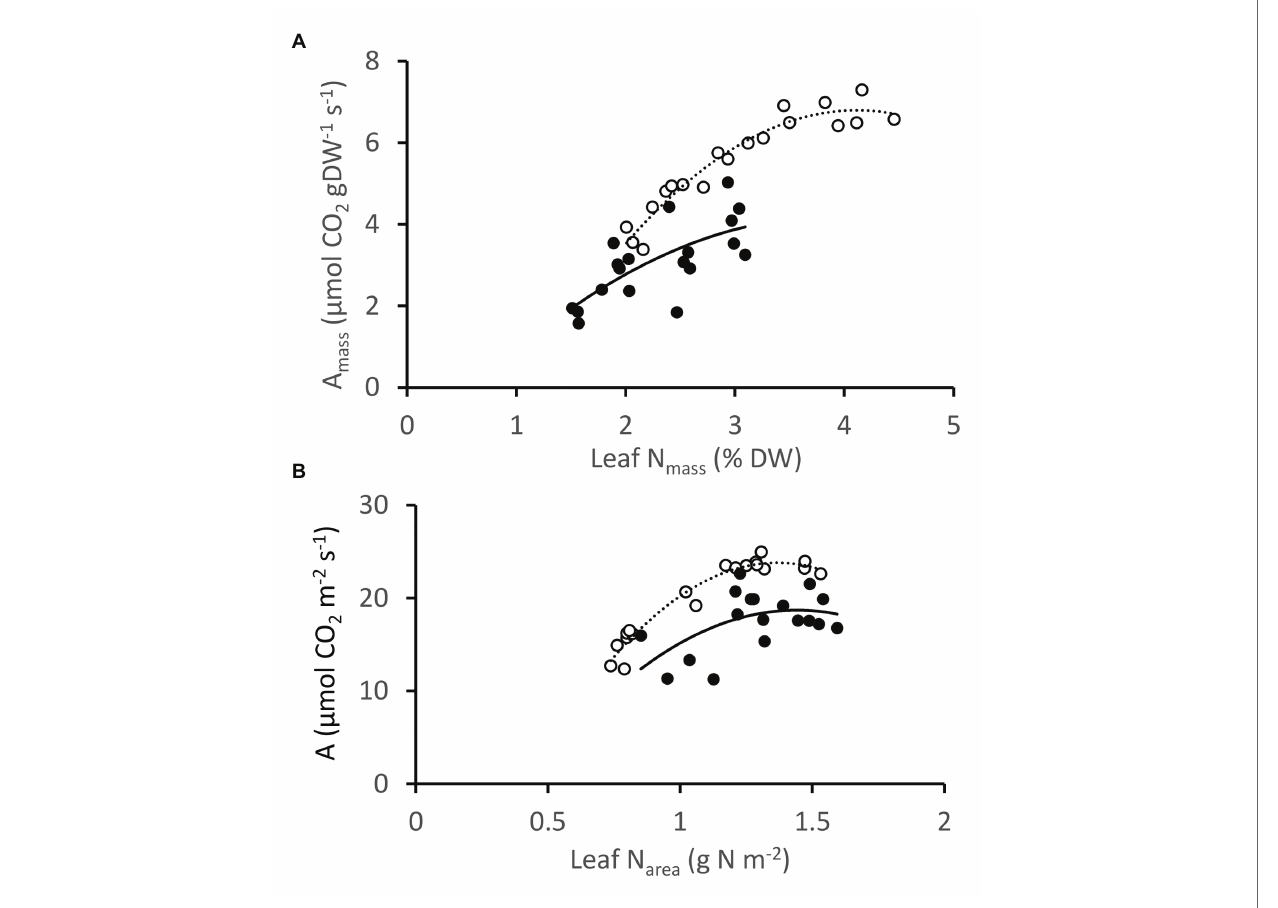
FIGURE 7 | Photosynthesis vs. leaf N, expressed on a mass (A) and area (B) basis for Lolium perenne DGAT + CO5 (open circles; ) and NT control NT3 (closed circles; ) grown under 1–7.5 mM NO 3− supply. Photosynthesis measurements were made at 1500 μ mol photons m −2 s −1